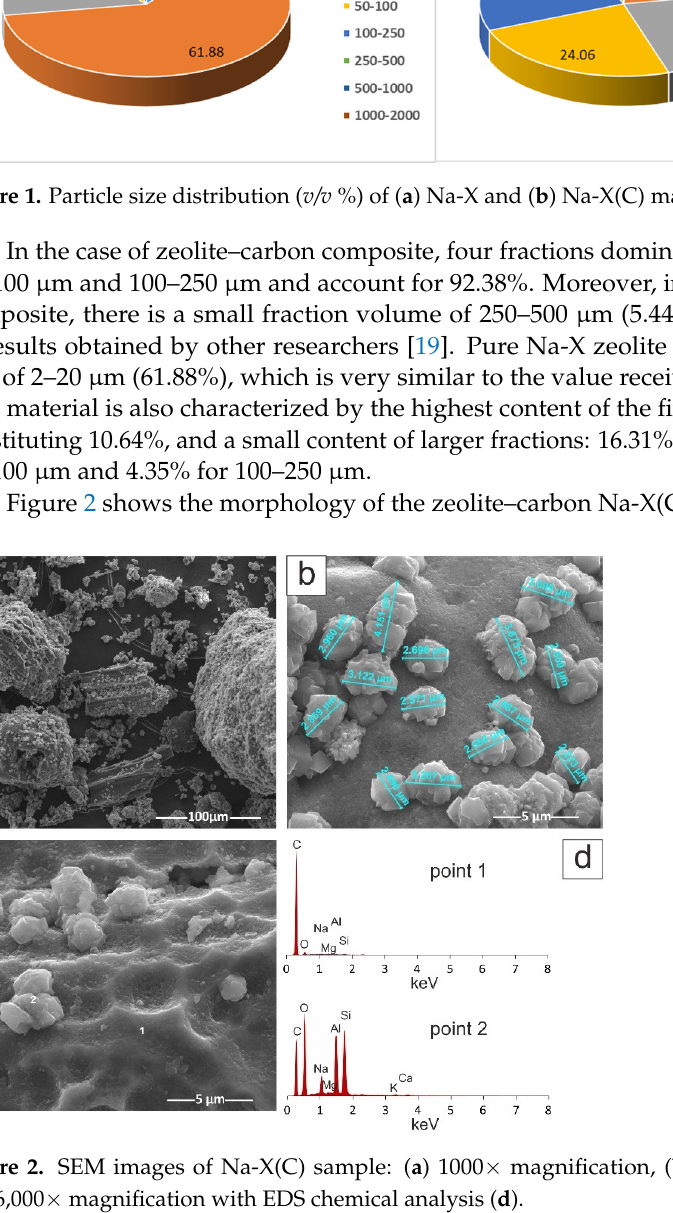
16,000× magnification with EDS chemical analysis ( d ). ( c ) 16,000 × magnification with EDS chemical analysis ( d